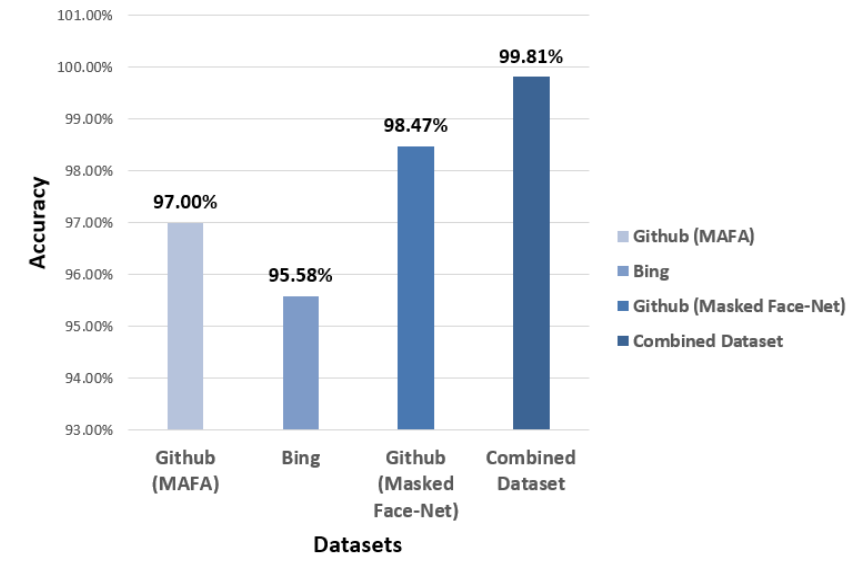
Figure 13. Comparative accuracy of VGG-16 on different